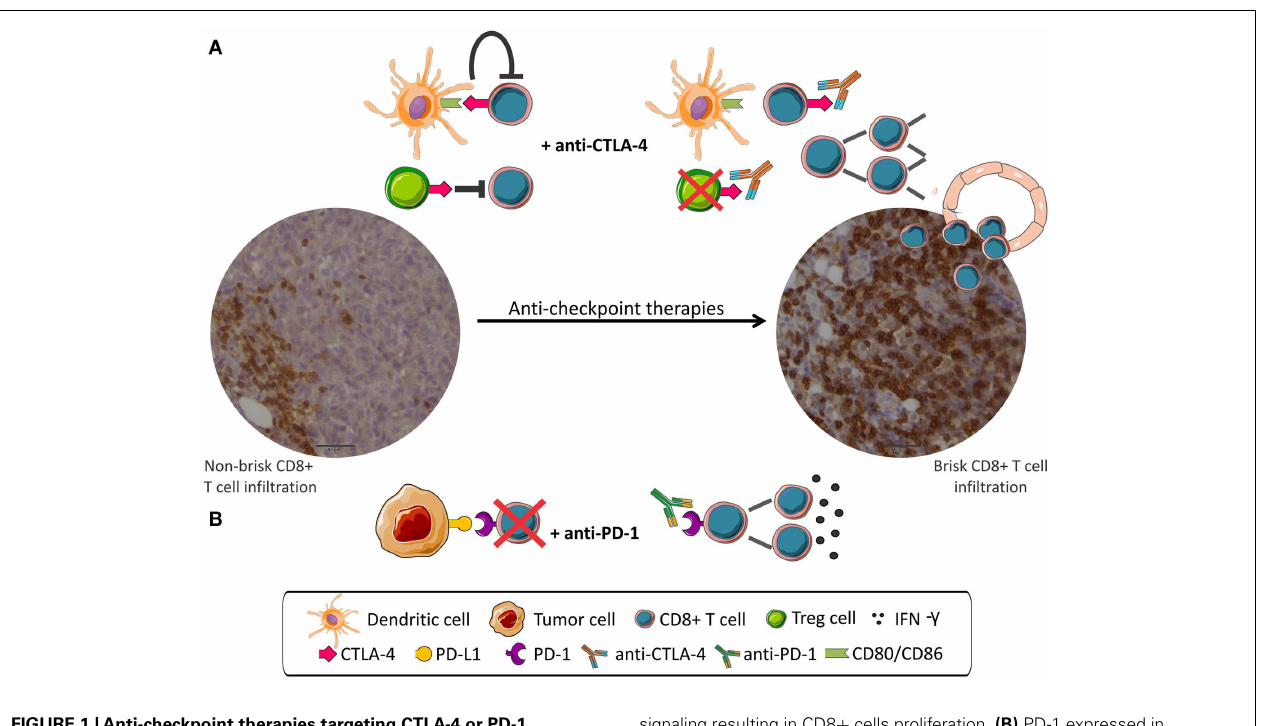
FIGURE 1 |Anti-checkpoint therapies targeting CTLA-4 or PD-1 . Peripheral CD8 infiltration (left) become tumor invasive (right) after anti-checkpoint treatment. (A) CD8 + T cells are inhibited by CTLA-4 signaling and byTreg cells. mAbs anti-CTLA-4 interrupt negative